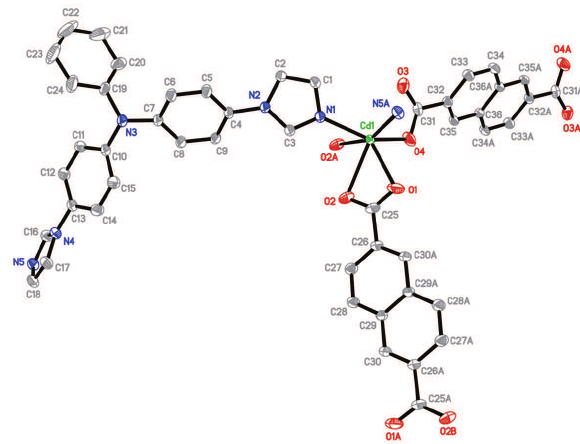
Table 2: Fractional atomic coordinates and isotropic or equivalent isotropic displacement parameters (Å 2